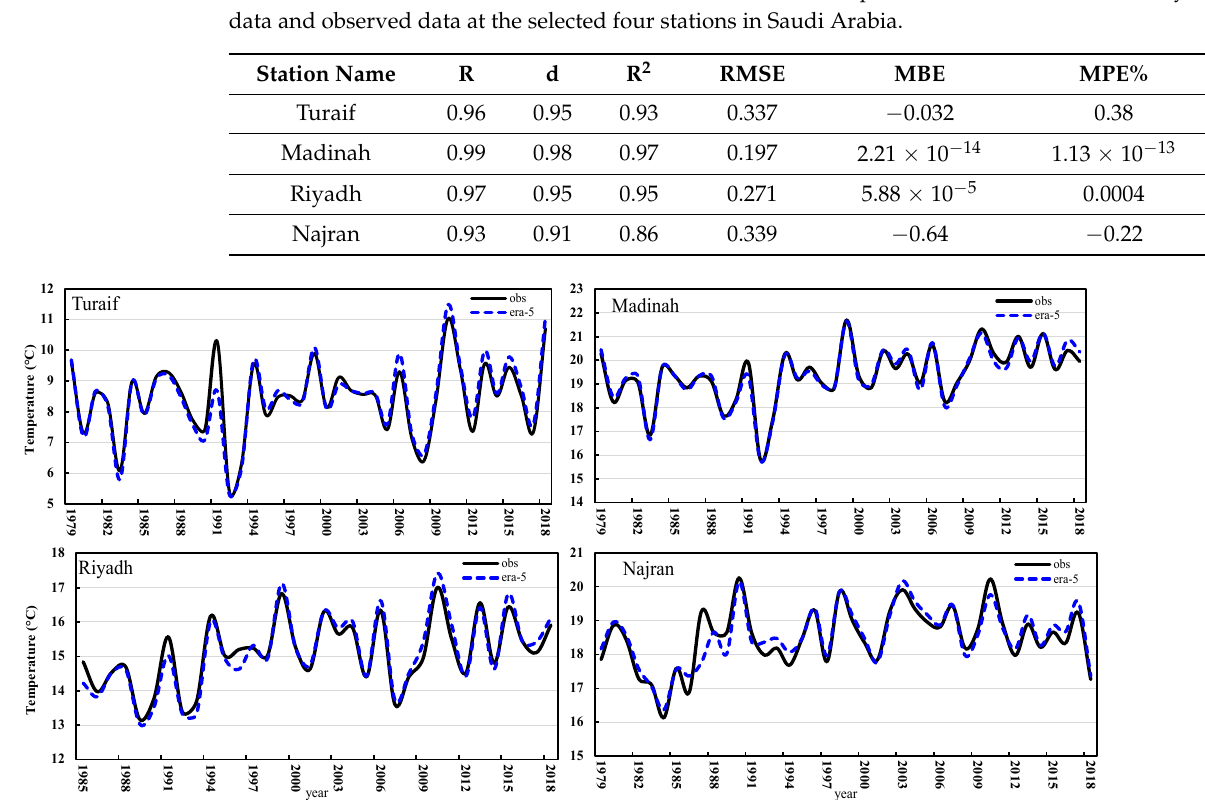
Figure 6. The comparison between ERA ‐ 5 Winter Air Temperatures data and its corresponding observed data for the stations Turaif, Madinah, Riyadh, and Najran.